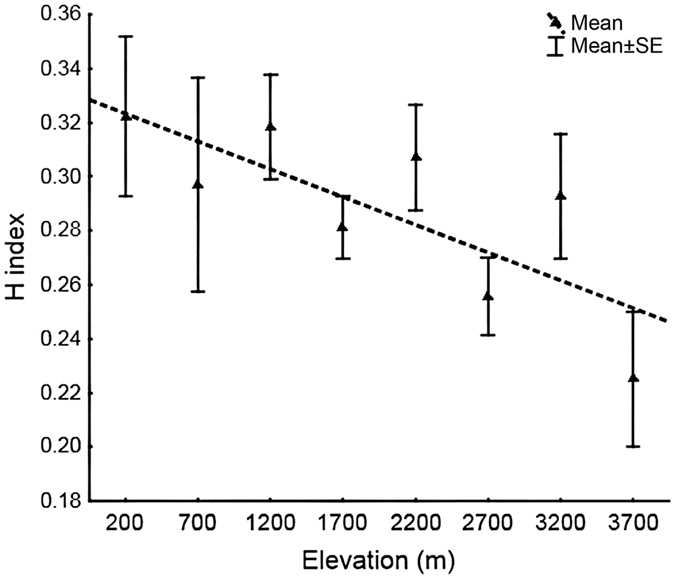
Brillouin diversity index (H) of invertebrate morphospecies in the diet of insectivorous birds along Mt. Wilhelm elevational gradient.